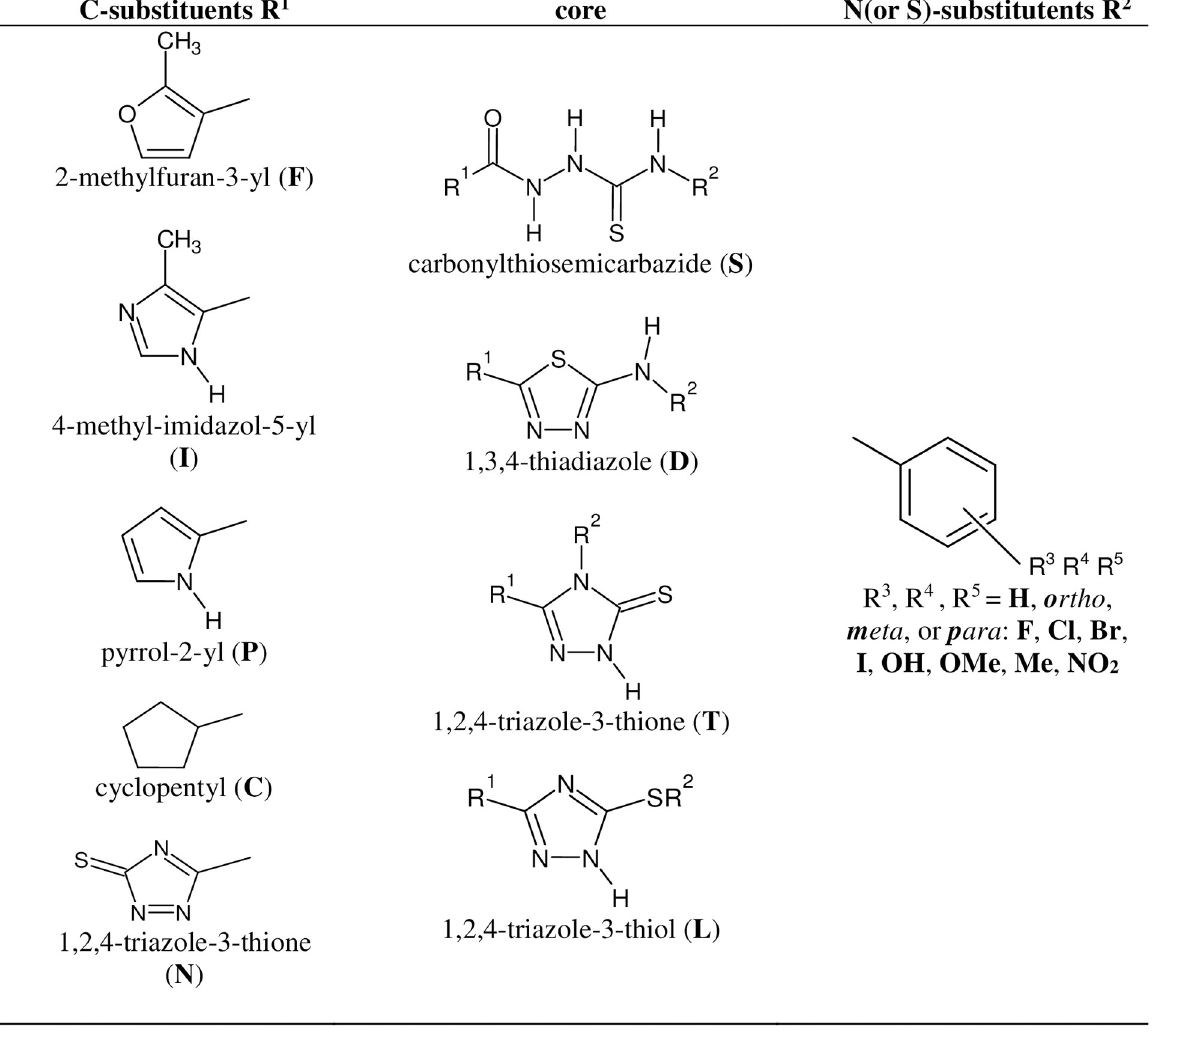
PLOS ONE | https://doi.org/10.1371/journal.pone.0256834 September 9,